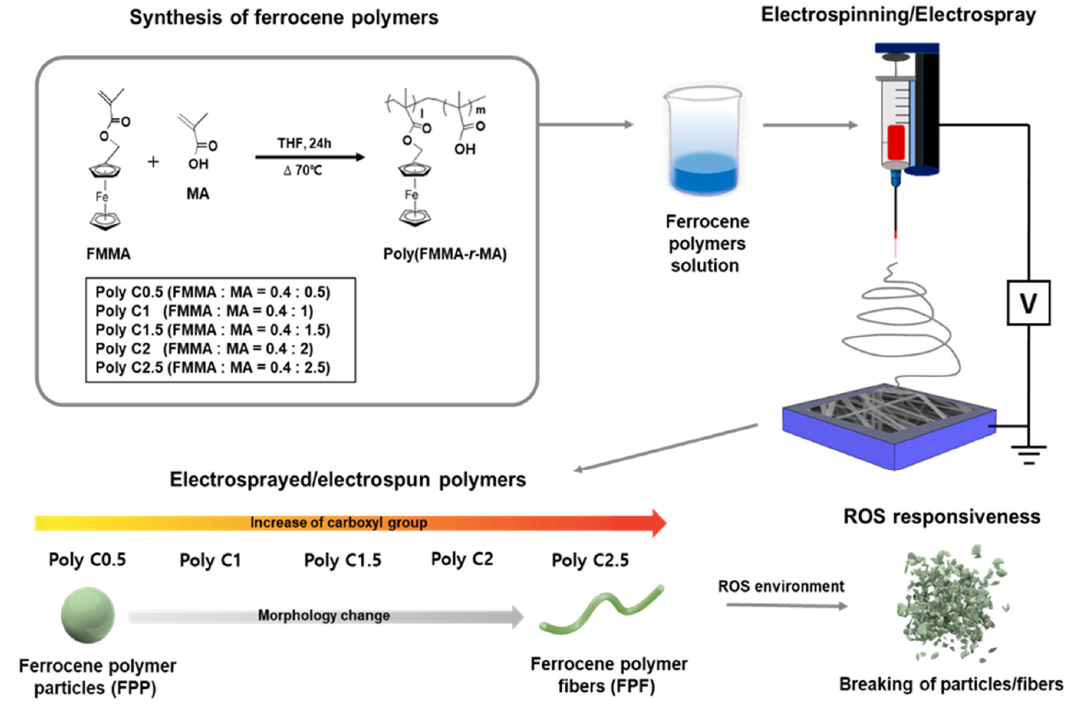
Figure 1. Schematics showing the synthesis of poly(FMMA -r- MA)) random copolymers and its use for fabricating a ferrocene polymer fiber (FPF) and a ferrocene polymer particle (FPP) with the electrospinning process.